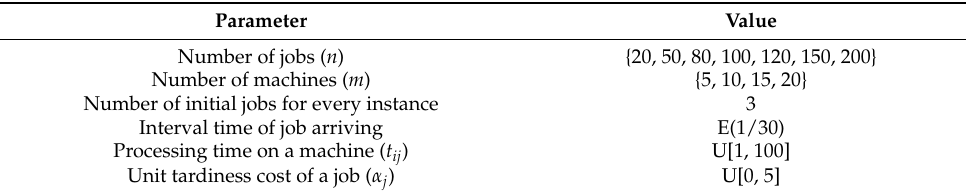
Table 1. Parameters for instances.